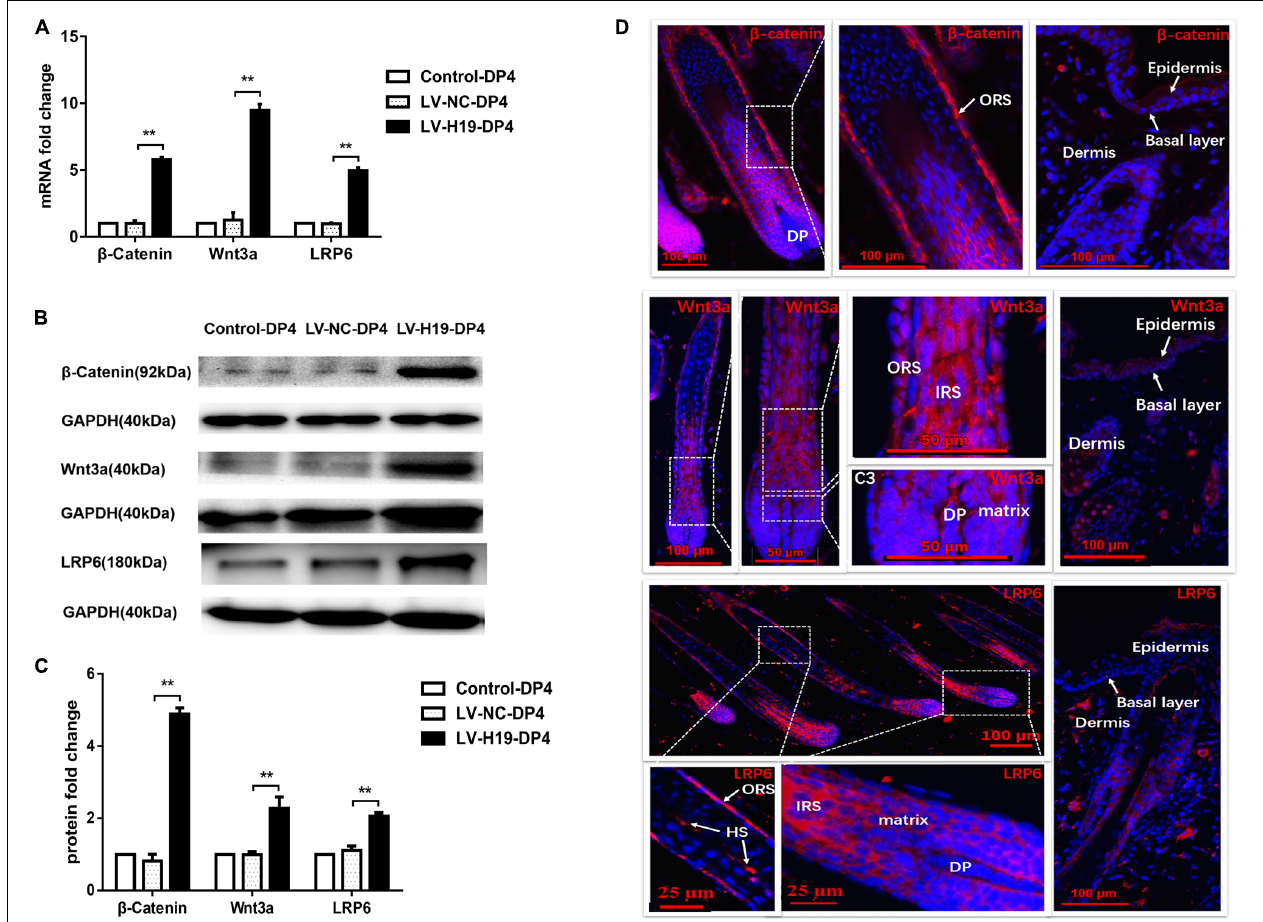
FIGURE 5 | Expression pattern of Wnt3a, β -catenin and LRP6 in the back skin of NU/NU mice. (A,B) Both mRNA and protein levels of Wnt3a, β -catenin and LRP6 significantly increased when injected with LV-H19-infected DP4 cells. (C) Wnt3a, β -catenin and LRP6 protein expression levels were quantified. (D) Immunofluorescence staining showed Wnt3a, β -catenin and LRP6 were strongly expressed in the outer root sheath (ORS), inner root sheath (IRS), and matrix. No expression was found in the epithelial basal layer. HS, hair shaft. Data shown represent the mean ± SEM of three independent experiments. ** P < 0.01.